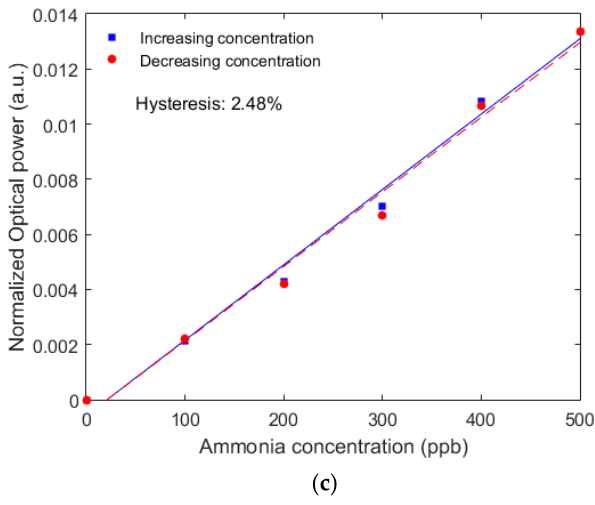
Figure 4. ( a ) Comparison between the fiberoptic probe responses with and without the PDMS layer as a function of the ammonia concentration. ( b ) Fiberoptic probe responses without PDMS layer as a function of time for two consecutive ammonia concentration cycles. ( c ) Hysteresis analysis of the proposed fiberoptic probe for ammonia detection.